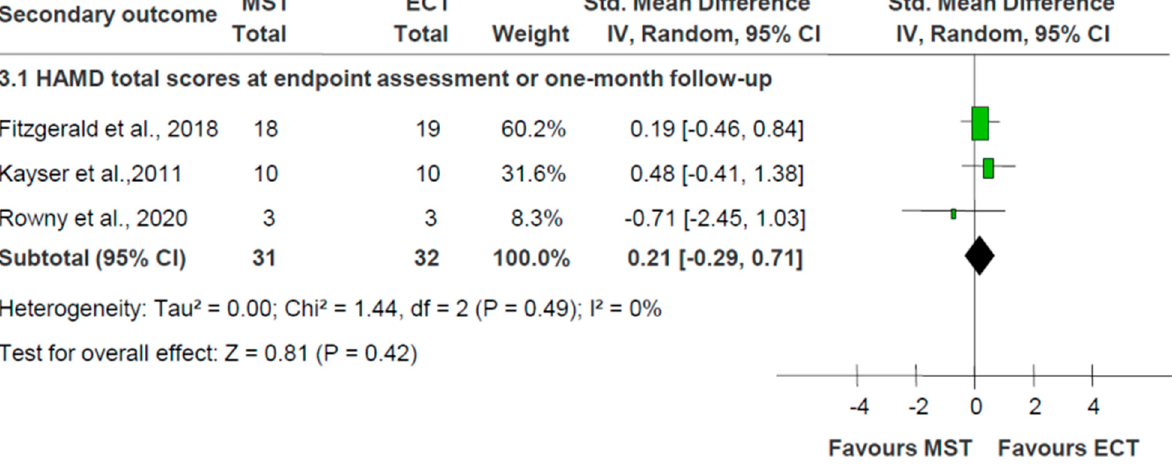
Figure 3. MST versus ECT for depression: forest plot for the improvement of depressive symptoms as measured by the HAMD. Abbreviations: ECT=electroconvulsive therapy; HAMD=Hamilton Depression Scale; MST=magnetic seizure therapy.